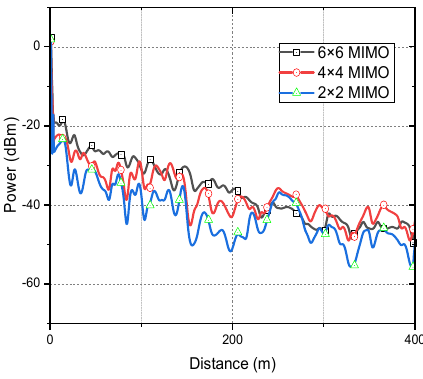
Fig. 4. Power versus distance between different MIMO systems.